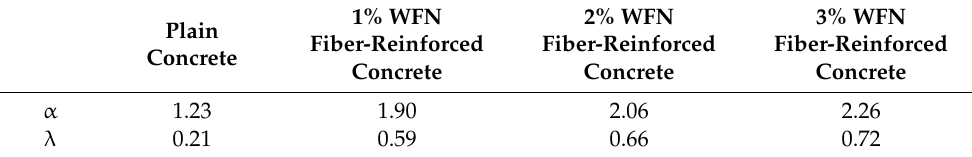
Table 9. Ductility number